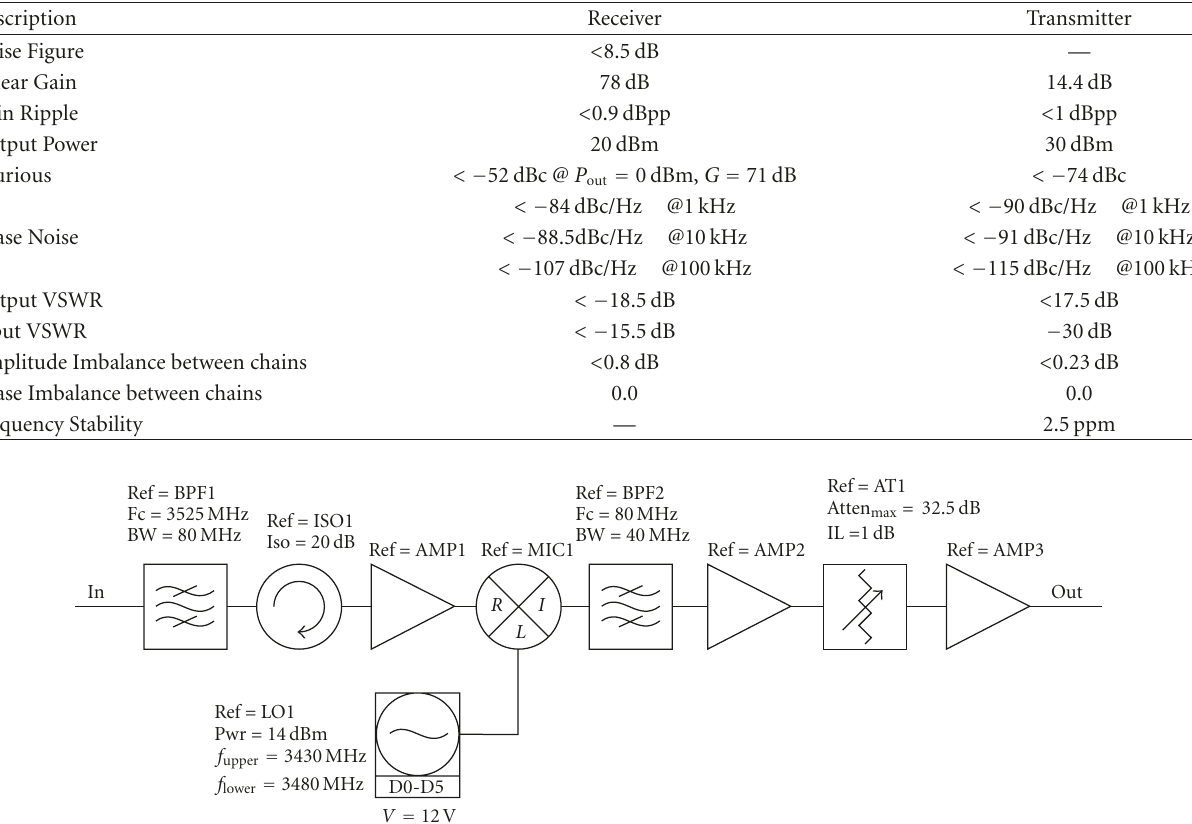
Table 1: RF specifications Summary.